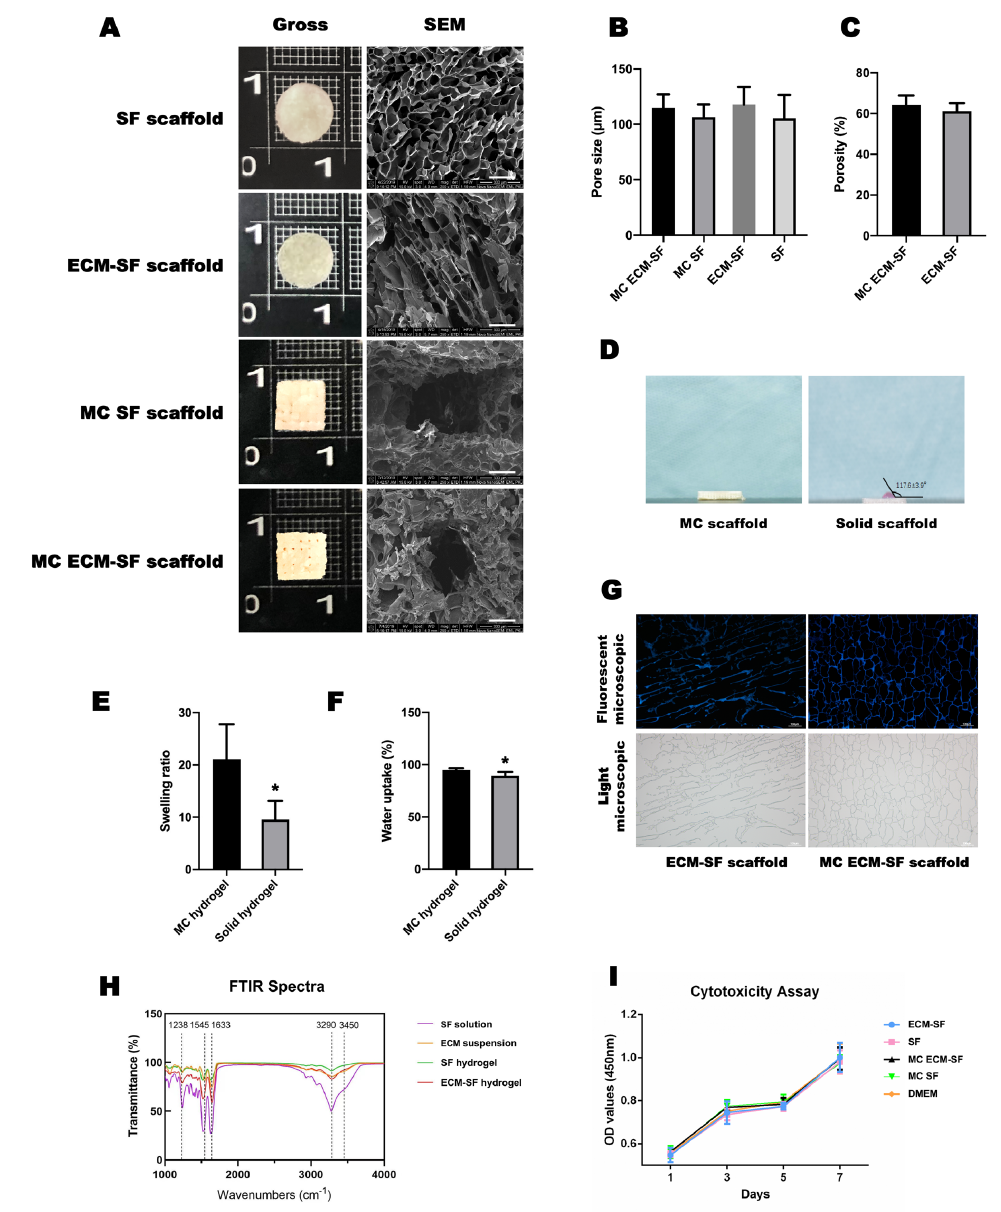
Figure 3. Structure and characterization of the scaffolds. ( A ). Gross view and ultrastructure of scaffolds, bar = 200 µ m. ( B ). Pore size. ( C ). Porosity. ( D ). Surface wettability. ( E ). Swelling index of hydrogel scaffolds. ( F ). Water uptake. ( G ). DAPI and light microscopy images, bar = 100 µ m. ( H ). FTIR spectra. ( I ). Cytotoxicity assay. “*” indicates a significant difference between the two groups with p < 0.05. Original magnification: ×250.